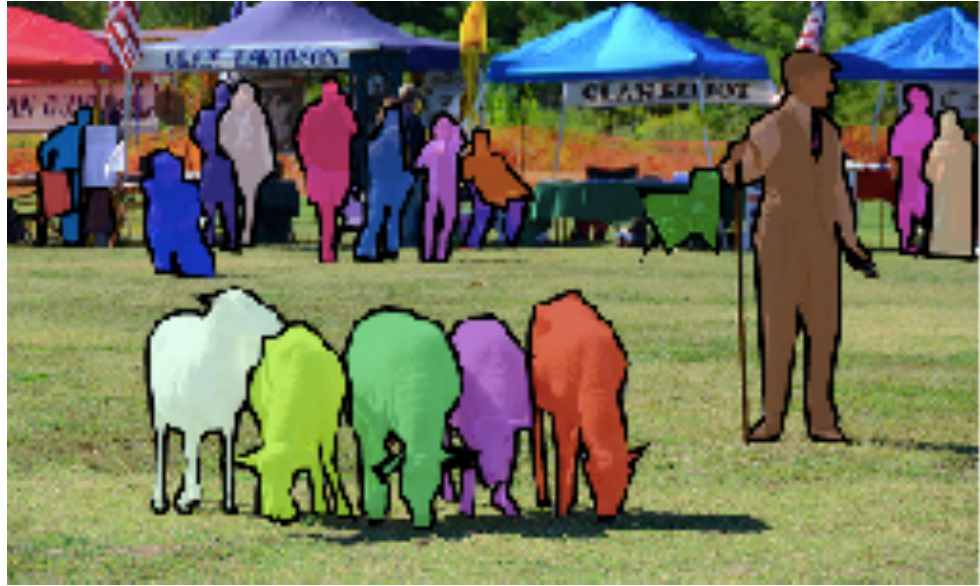
Figure 1. Image from the Microsoft COCO data set in which there are several instances of multiple objects/class labels, e.g., sheep, people. (adapted from https://cocodataset.org/#detection-2020 (accessed on 21 March